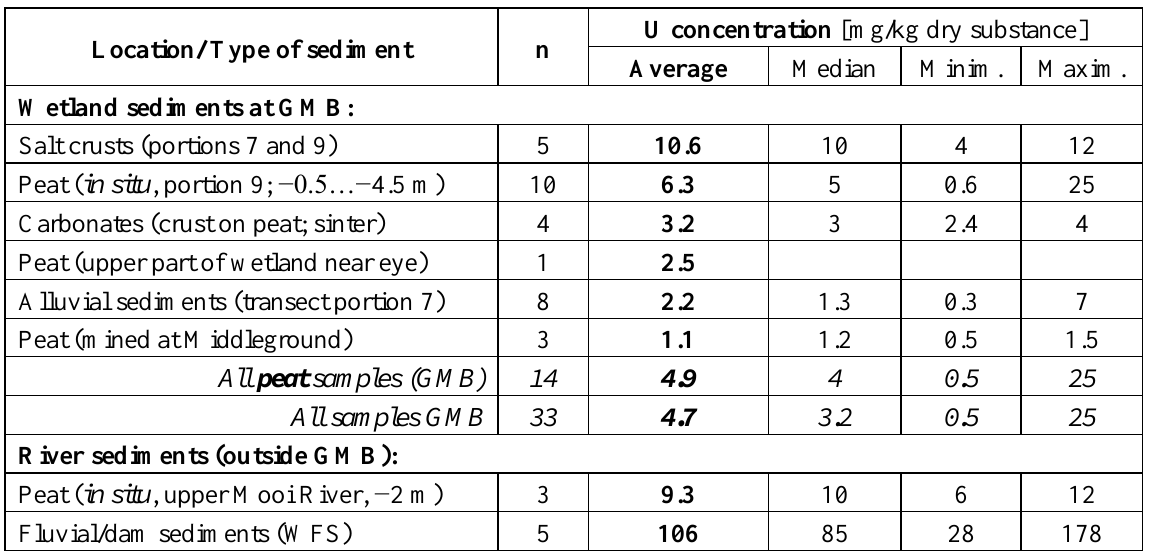
Table 2. U levels for different sediment types in the Gerhard Minnebron wetland in comparison to U concentrations in peat from the upper Mooi River and fluvial sediments from the Wonderfonteinspruit as found in the survey (n—number of samples). U concentration [mg/kg dry substance] Location/ Type of sediment n Average Median Minim.